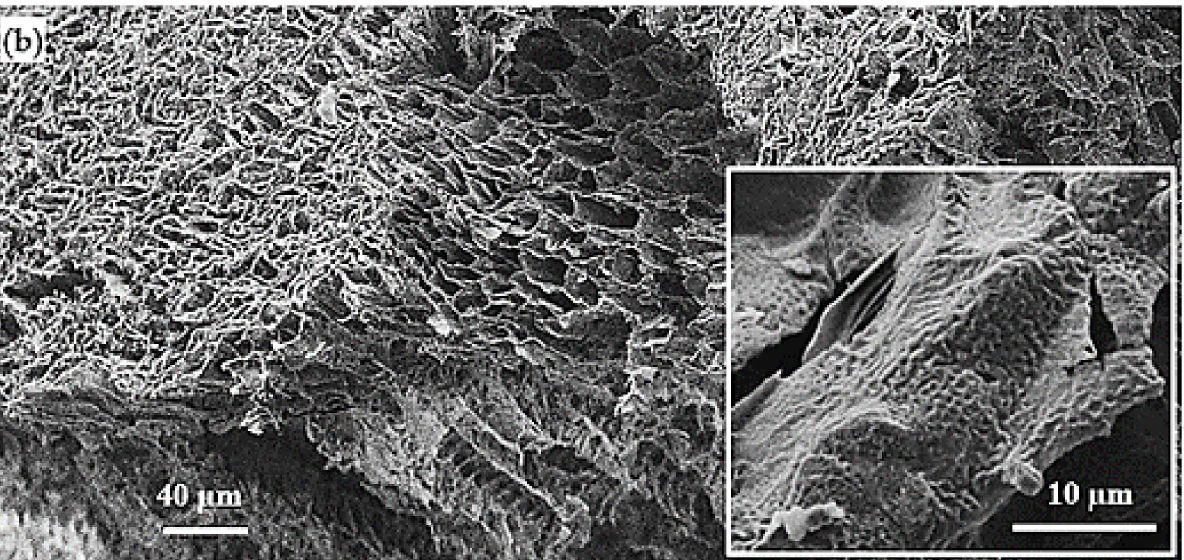
Figure 15. SEM micrograph of the PBS/poly(PA-LO) scaffold prepared under uniaxial temperature gradient condition at − 196 ◦ C: top surface ( a ), cross-section ( b ). Left inset of ( a ) shows a higher magnification of the corresponding surface. Right insets show spherulites with high magnification from the cross-section of oriented scaffolds made of neat PBS ( a ) [25] and PBS/poly(PA-LO) ( b